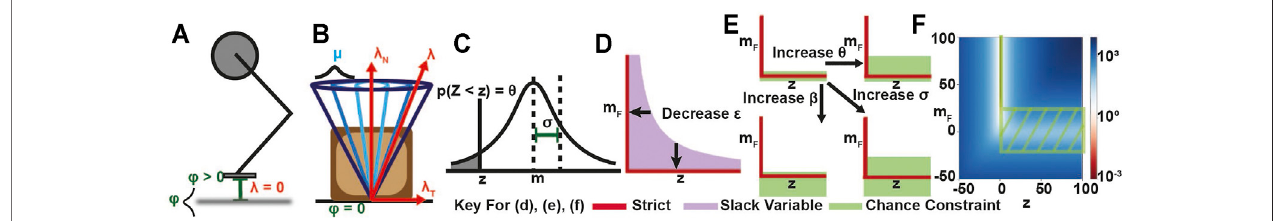
FIGURE 1 | (A,B) Contact geometry of the hopper and block examples, respectively, with uncertainty in (A) terrain height and (B) friction coef fi cient. (C) Gaussian distribution with mean m and standard deviation σ , where p ( Z < z ) (cid:2) θ . (D) Relaxed complementarity constraint region for comparison with (E) chance complementarity constraintfeasibleregionsfordifferentriskbounds. (F) OverlapbetweenERMcostmapandchancerelaxedfeasibleregionat σ (cid:2) 10.Athighuncertainty,lowERMvalues approach the positive m F axis and the chance constraint region widens around the non-negative z